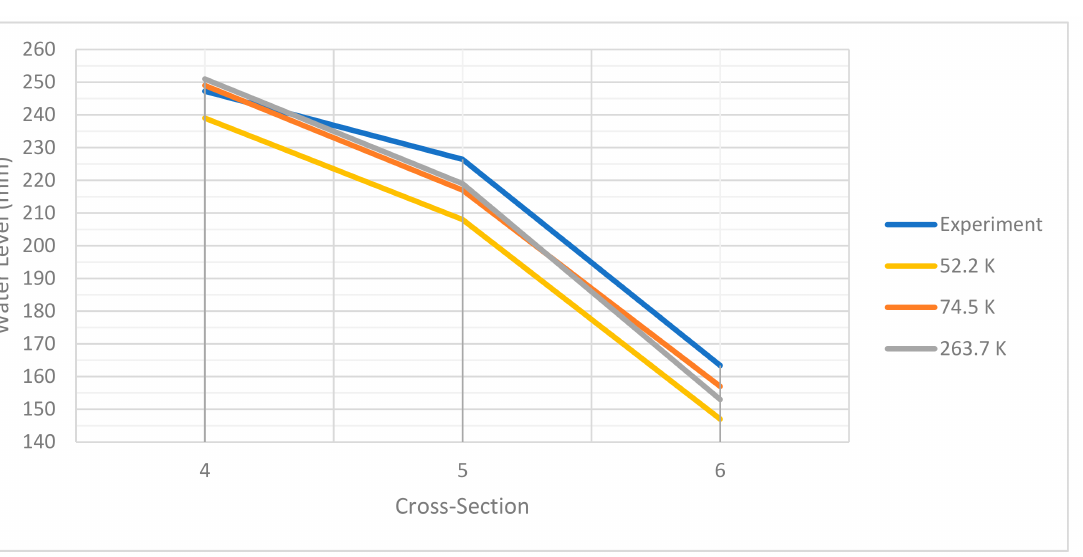
Figure 3. Mesh analysis graphs for the cross-section